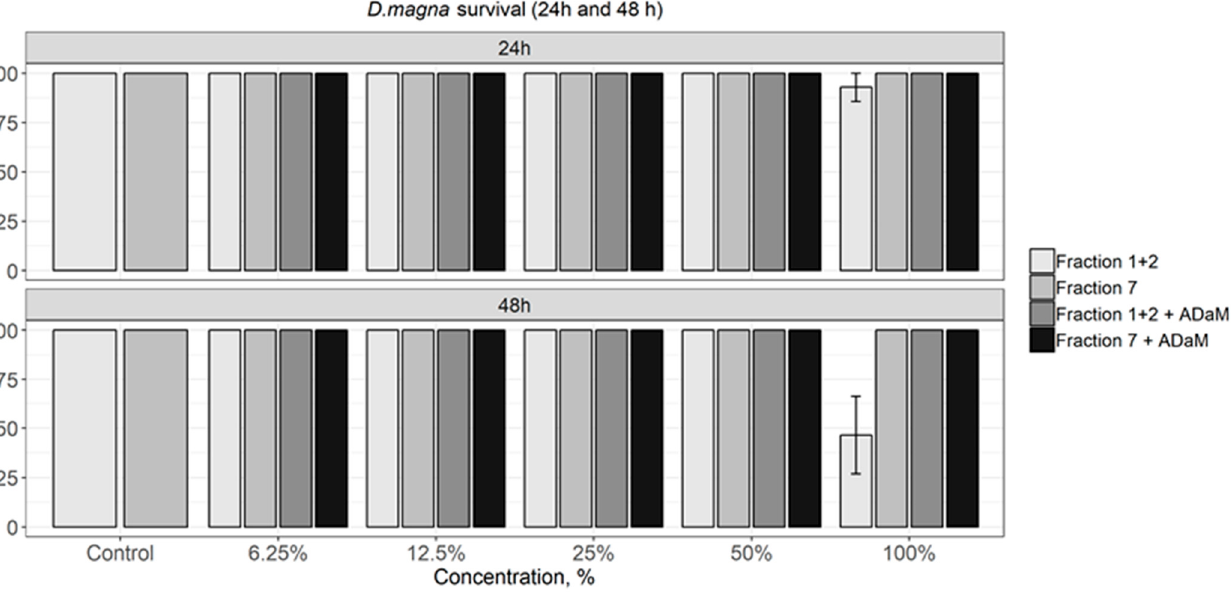
Figure 6. Survival of Daphnia magna after 24 h and 48 h.